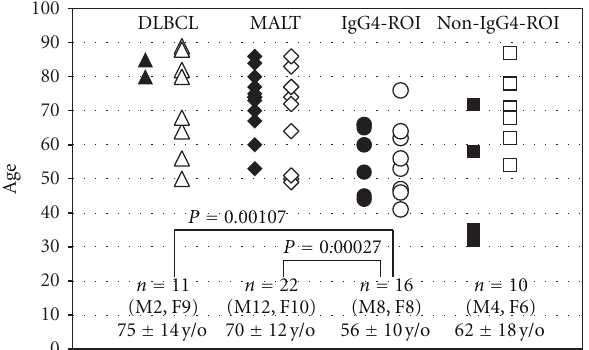
Figure 2: Ages of orbital lymphoproliferative disorders. Each plot depicts age at diagnosis in groups of MALT lymphoma, DLBCL (di ff use large B-cell lymphoma), IgG4-related orbital inflammation and non-IgG4-related orbital inflammation. Closed and open plots represent men and women,